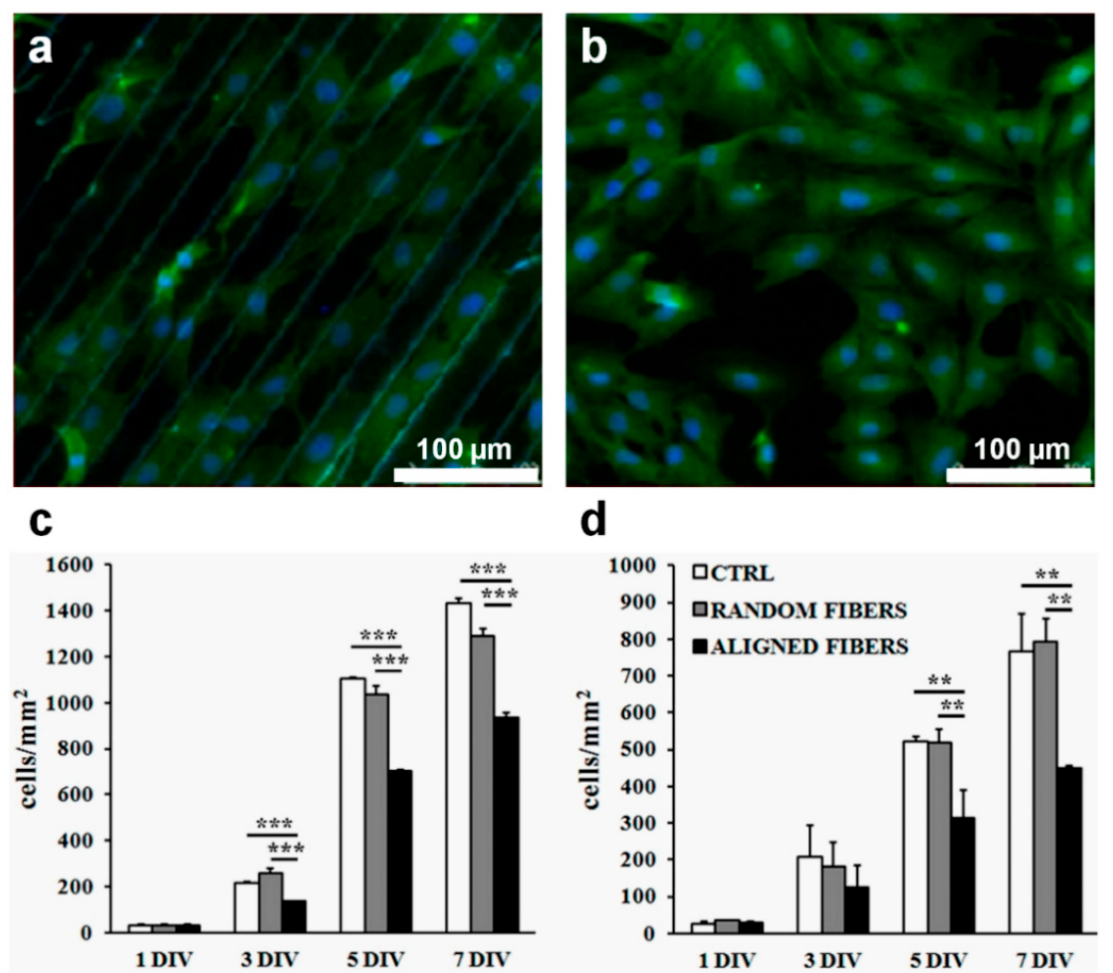
Figure 8. ( a , b ) Optical micrographs revealing the behavior of Schwann cells on a substrate patterned with 30 µ m wide chitosan grooves ( a ) and on a flat chitosan control substrate ( b ). ( c , d ) Proliferation of RT4-D6P2T ( c ) and primary Schwann cells ( d ) on substrates covered with aligned and random gelatin fibers, as well as on control poly-L-lysine coated coverslips. Asterisks ** and *** indicated significant statistical differences with p ≤ 0.01 and p ≤ 0.001, respectively. Adapted with permission from ref. [61] ( a , b ) and ref. [154] ( c , d ).